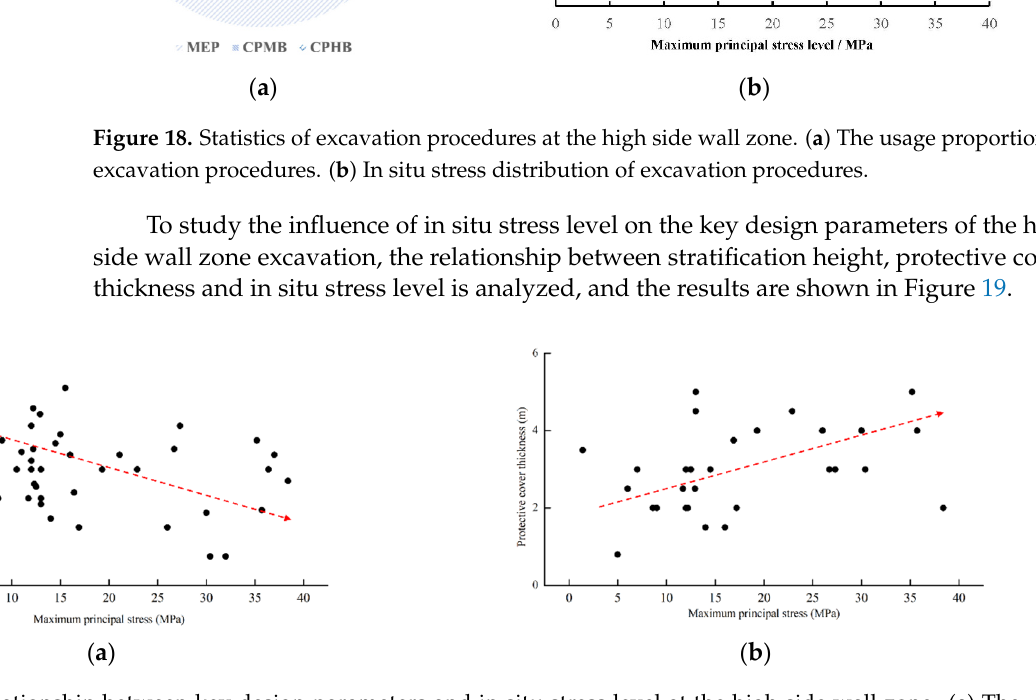
Figure 18. Statistics of excavation procedures at the high side wall zone. ( a ) The usage proportion of excavation procedures. ( b ) In situ stress distribution of excavation procedures.